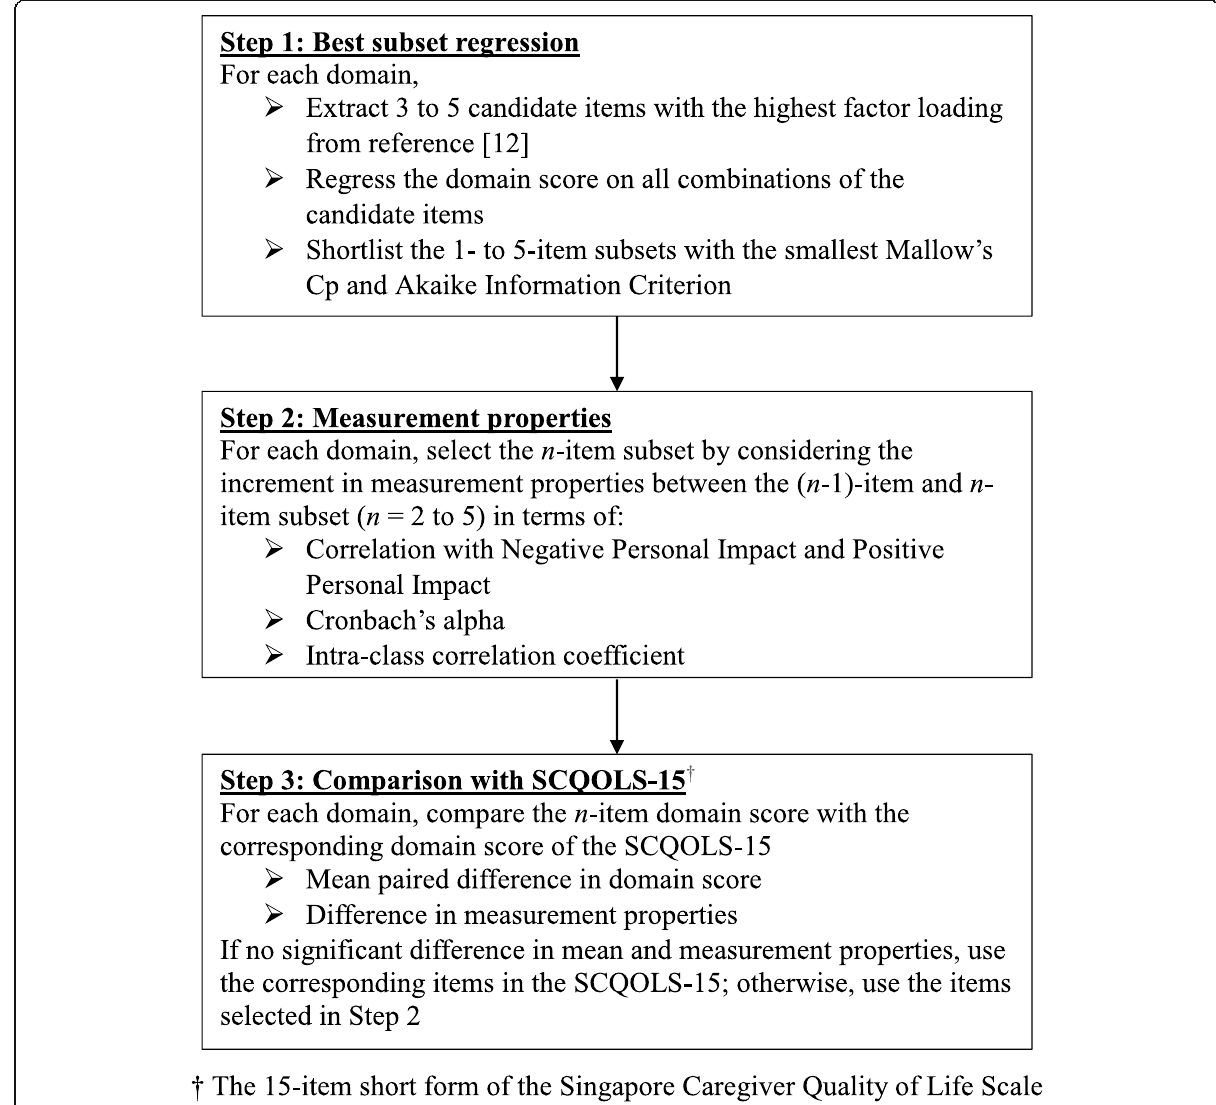
Fig. 1 Process of developing the short form of the Singapore Caregiver Quality of Life Scale –